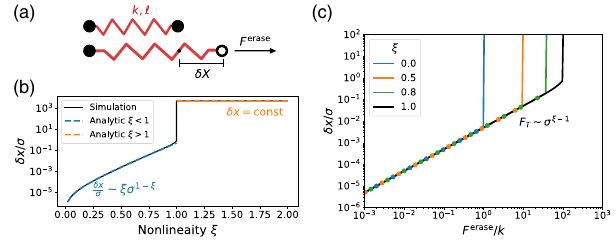
FIG. 4. Nonlinear ξ ≤ 1 springs are essential for continual learning. (a) An unstrained spring is extended by δ x due to an external force F erase . (b) Net displacement δ x of a previously stable point x ð 1 Þ due to forces F erase arising from springs learned for a new state x ð 2 Þ . δ x ≪ σ for ξ ≤ 1 springs, yet δ x is extended for ξ > 1 springs. (c) A threshold erasure force F T ∼ σ ξ − 1 is required to destabilize the stable state due to nonlinear ξ ≤ 1 springs. Small σ and ξ ≤ 1 springs are thus essential for stabilizing previous states under continual learning of new states ( σ ¼ 10 − 4 L